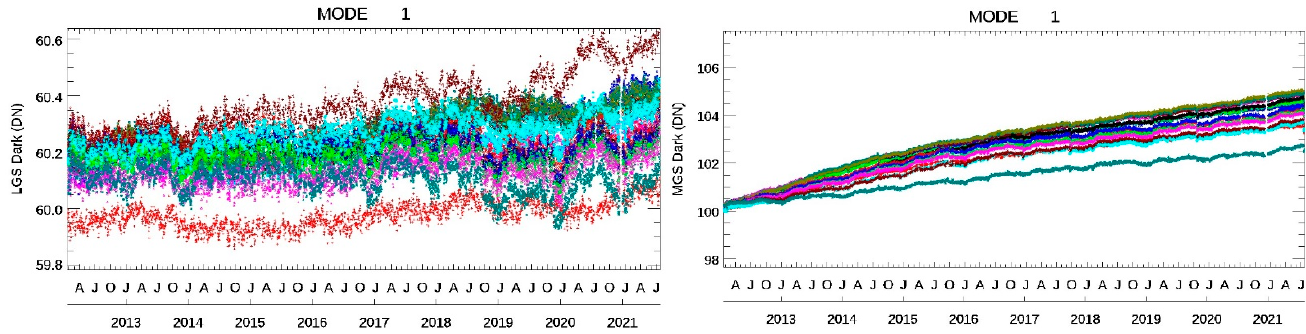
Figure 6. DNB dark signals of Mode-1 in LGS and MGS. Different colors are used to plot the DNB 16 detectors.